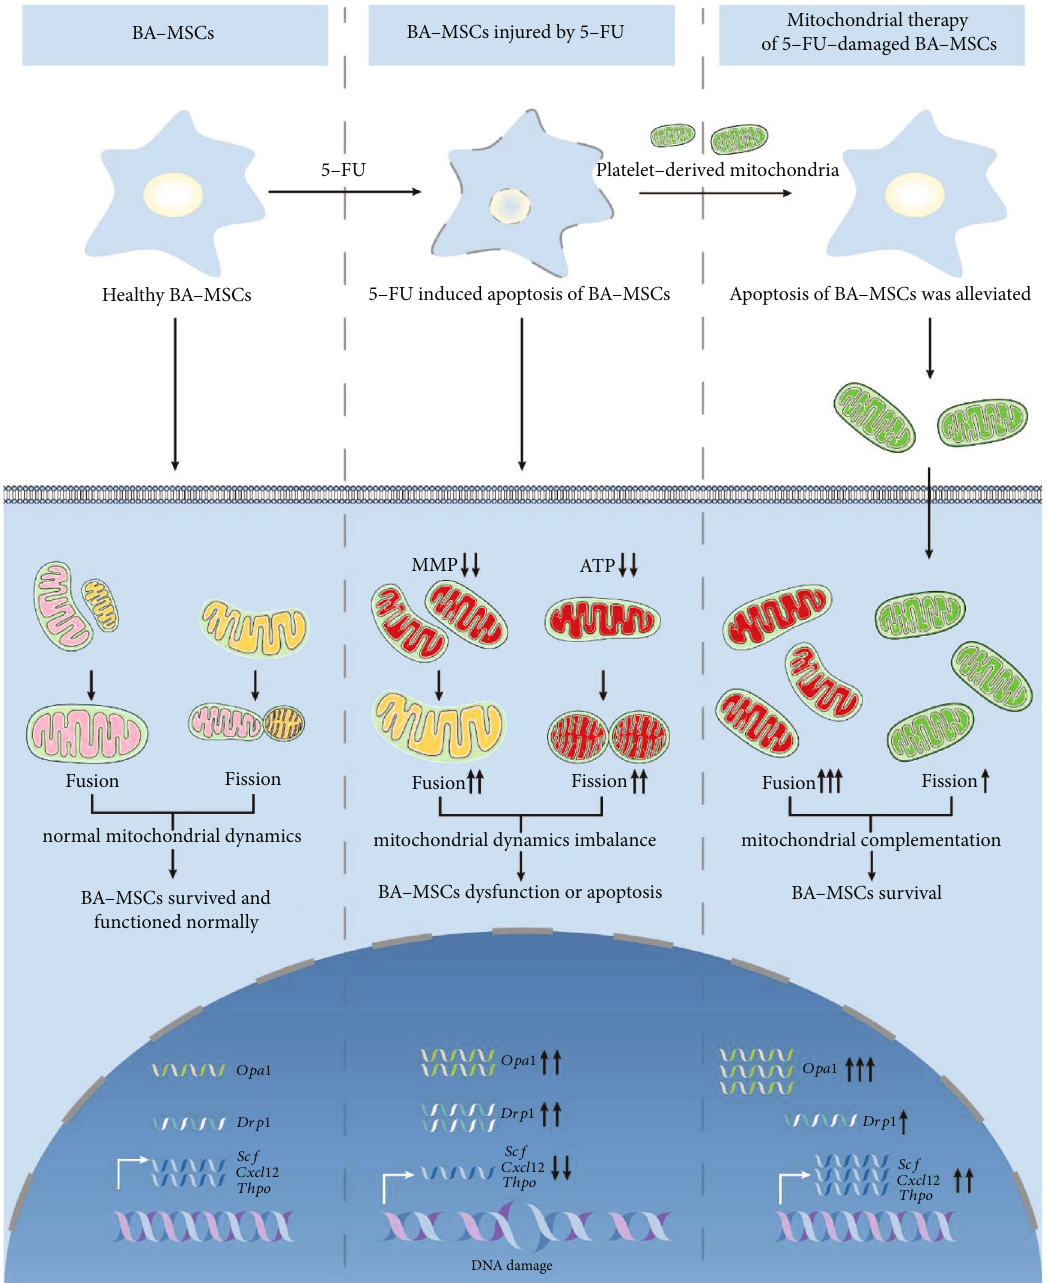
Figure 8: Schematic summary of the process and mechanism of our study. 5-FU induces the apoptosis of BA-MSCs, and platelet-derived mitochondria attenuates 5-FU-induced apoptosis of BA-MSCs. 5-FU chemotherapy can damage mitochondrial dynamics, mitochondrial functions, and expression of hematopoietic regulatory factor genes in BA-MSCs. However, under the treatment of platelet-derived mitochondria, the damage of mitochondria and hematopoietic regulatory function of BA-MSCs was alleviated. Mitochondria marked in pink: healthy mitochondria of BA-MSCs. Mitochondria marked in yellow: slightly damaged mitochondria of BA-MSCs. Mitochondria marked in red: severely damaged mitochondria of BA-MSCs. Mitochondria marked in green: platelet-derived healthy